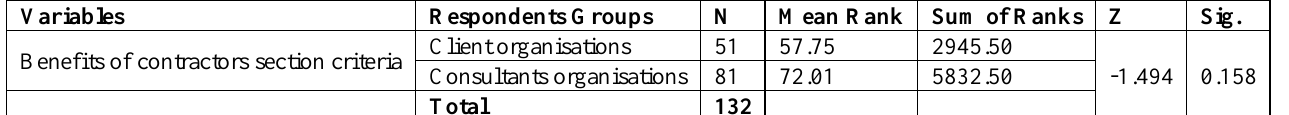
Table 8: Mann-Whitney U test for benefits of contractors section